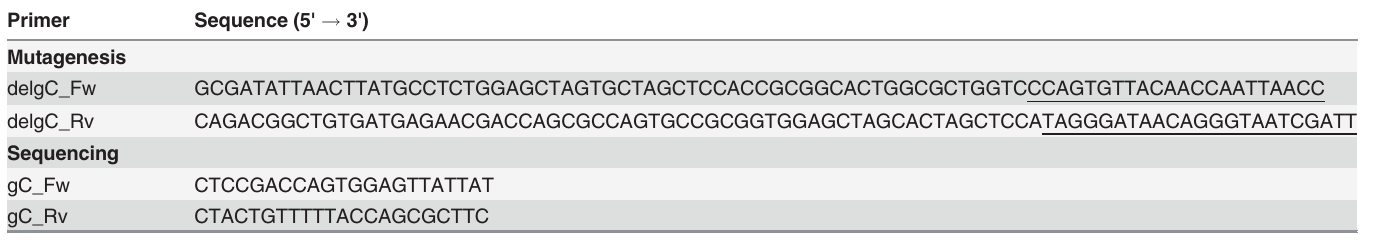
Table 1. Synthetic oligonucleotides for engineering and sequencing of the gC deletion mutant of